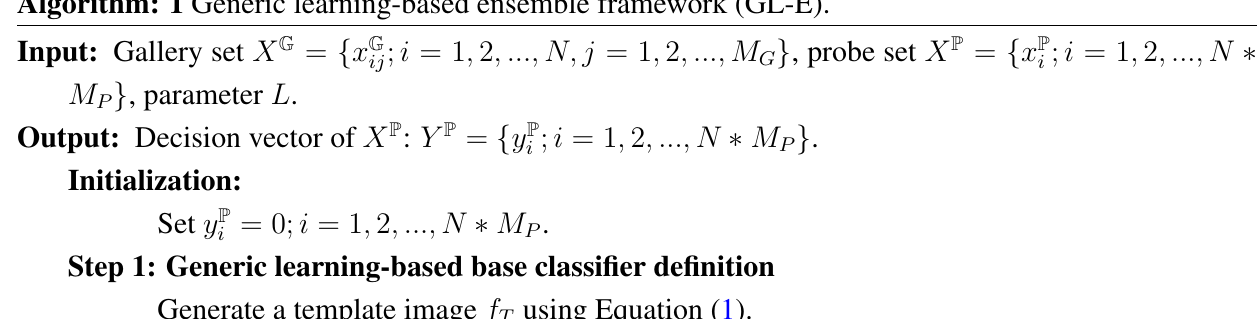
Algorithm: 1 Generic learning-based ensemble framework